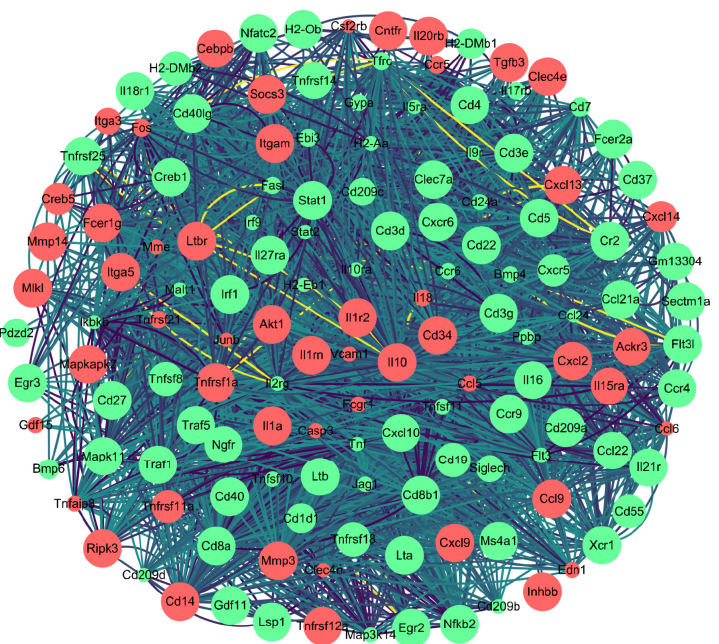
Figure 9. A total of 142 DEGs related to immune response were screened. Red, up-regulated genes; green, down-regulated genes. Depth of the line represents the degree of association, where a deeper line represents the closer the relationship between two proteins was, and size of the dot represents the significance of p values, where a larger size indicates higher significance.